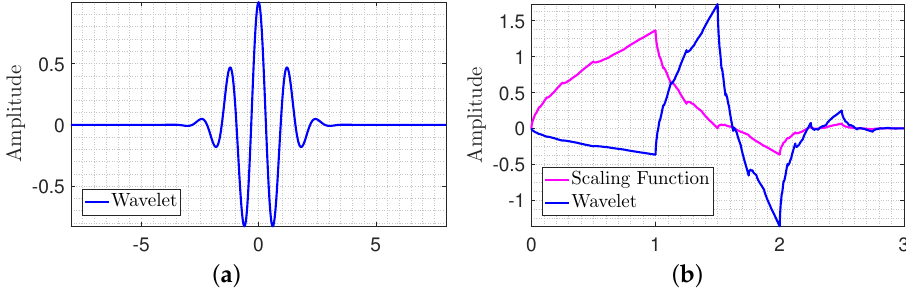
Figure 3. Visualization of wavelet functions. ( a ) Morlet wavelet; ( b ) Daubechies